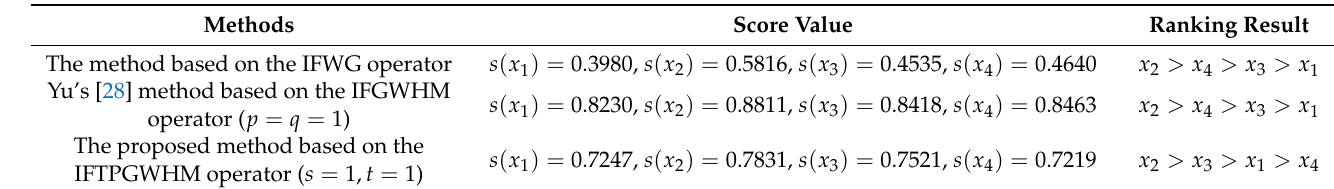
Table 6. Comparison of the